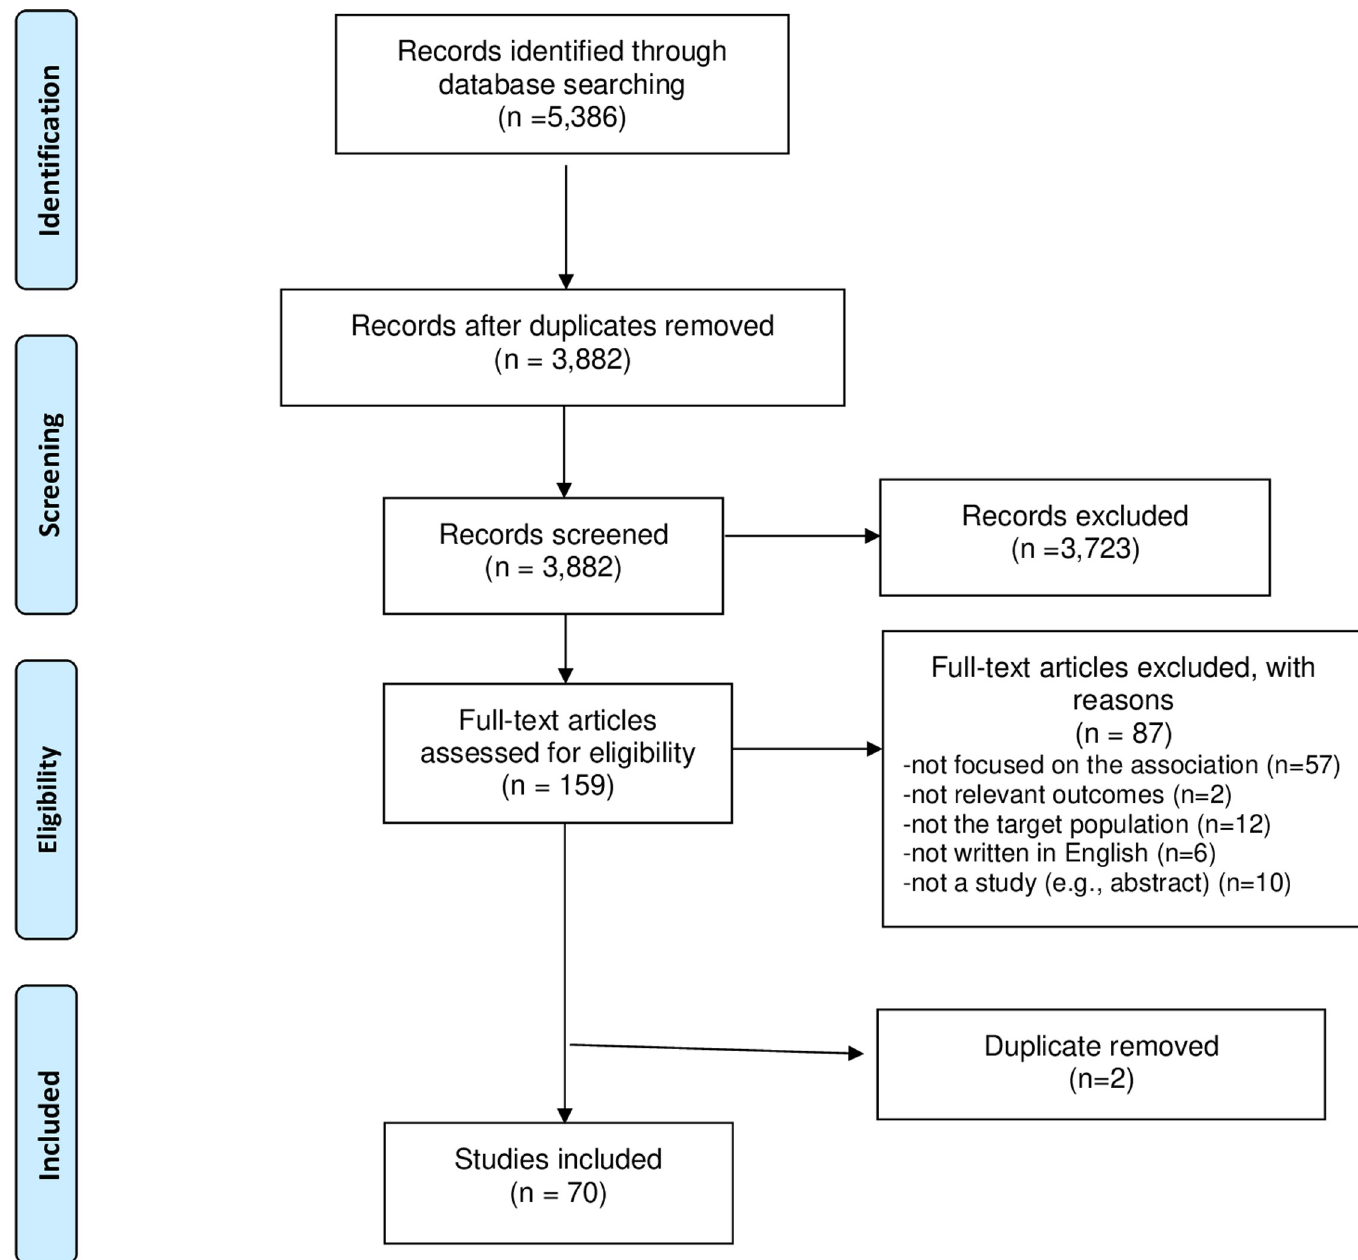
Fig 1. PRISMA-ScR flow diagram for the study selection